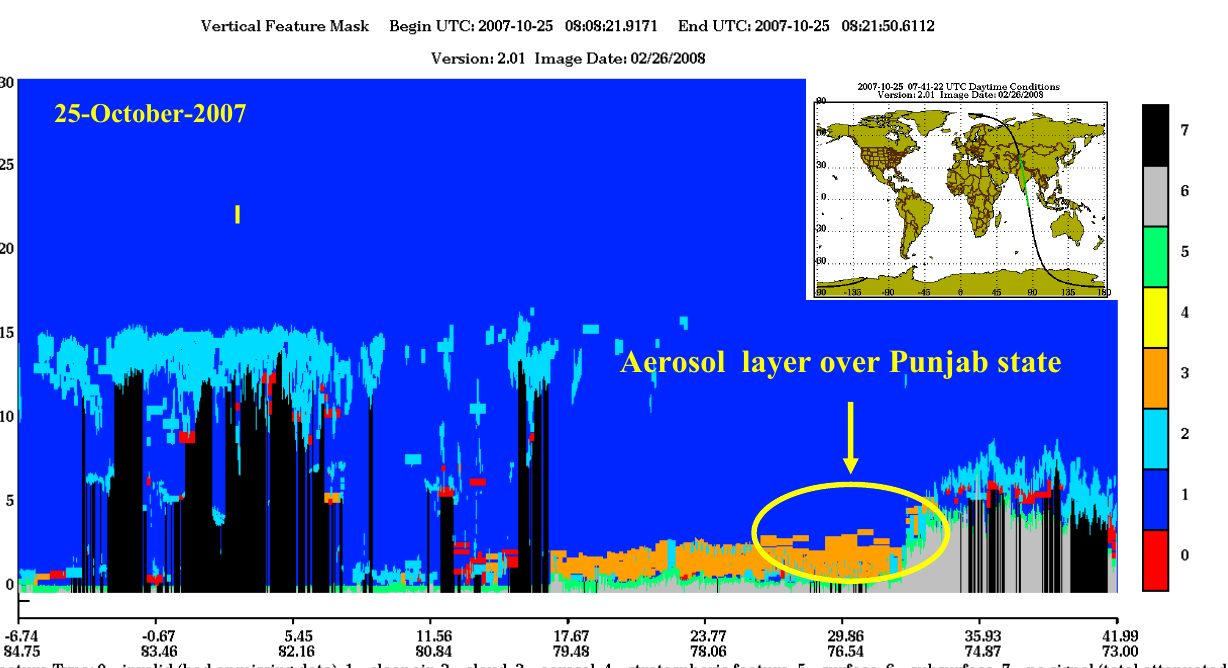
Fig. 12. Calipso derived vertical feature mask image showing high aerosol loading over central region of India on 25 October 2007.